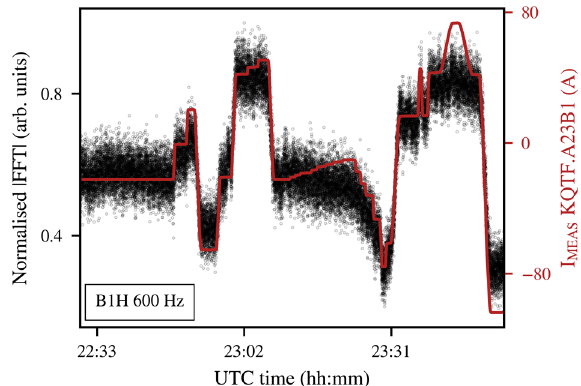
FIG. 12. The amplitude evolution of the 600 Hz lines (black) during the change of the phase advance between IP1 and IP5. while the tune is kept constant. The red line represents the current in the quadrupole trims employed for the phase